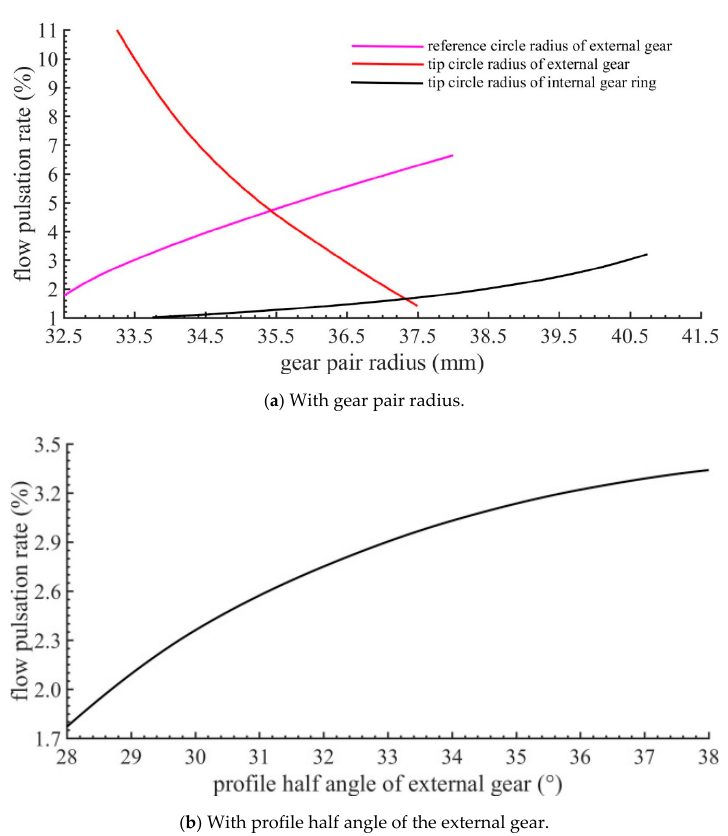
Figure 8. Change laws of the geometric flow pulsation rate.